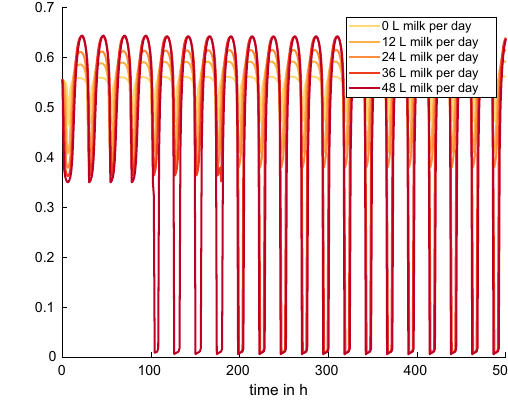
(a) Dynamics of K ECF (pink, in mmol/L) and K ICF (green, in mmol/L) (b) Dynamics of Gluc B (in g/L) with varying milk production. For 48 with varying milk production. With increasing milk production, K ECF L milk production per day, hypoglycemic values of Gluc B occur from and K ICF values decrease and stabilize at lower levels. the beginning but recover, until the stores are empty after 102 h. Figure 5. Experiment 4: increased potassium excretion with milk (default model setting, milk yield variation between 0 and 48 L milk per day).